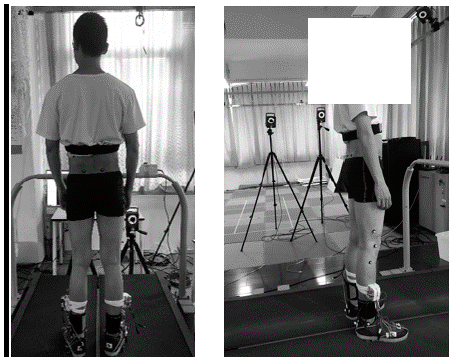
Figure 4. Subject and experiment setup.